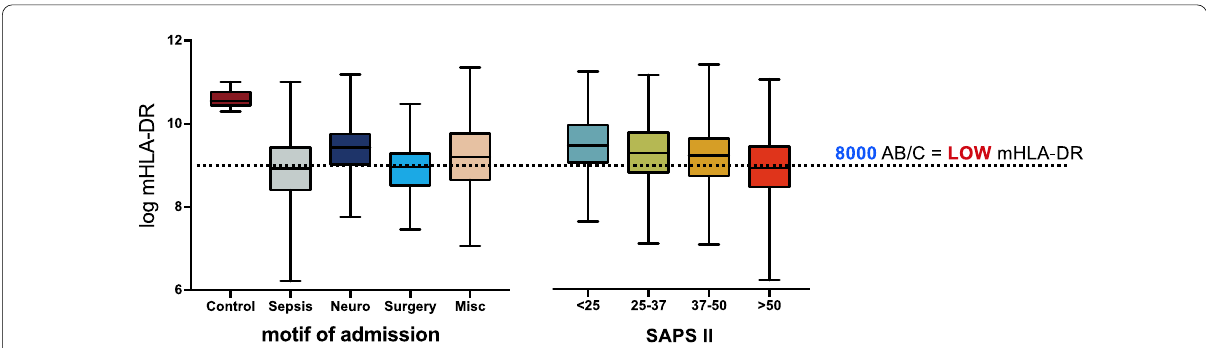
Fig. 1 Initial mHLA-DR measurement according to the motif of admission and initial severity, comparison with controls. Low mHLA-DR expression is defined by a level <